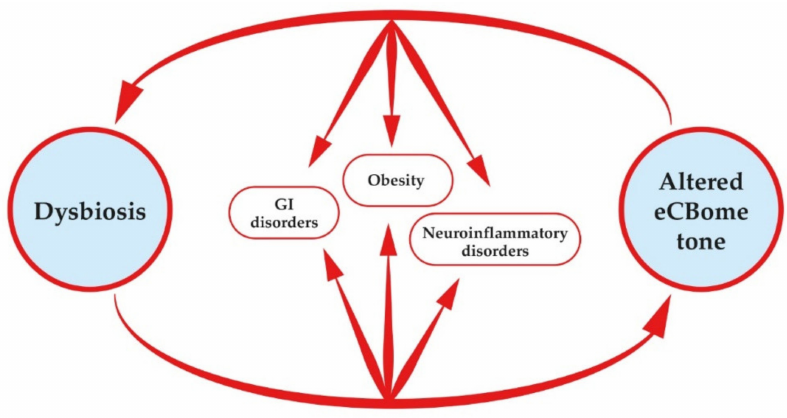
Figure 2. Crosstalk between the gut microbiota and the eCBome. Dysbiosis causes an altered tone of the eCBome, which in turn can feedback on dysbiosis. Disrupted cross talk between these two complex systems is involved in the pathogenesis of gut inflammatory diseases, obesity and neuroinflammatory and mood disorders (e.g., neuropathic pain and